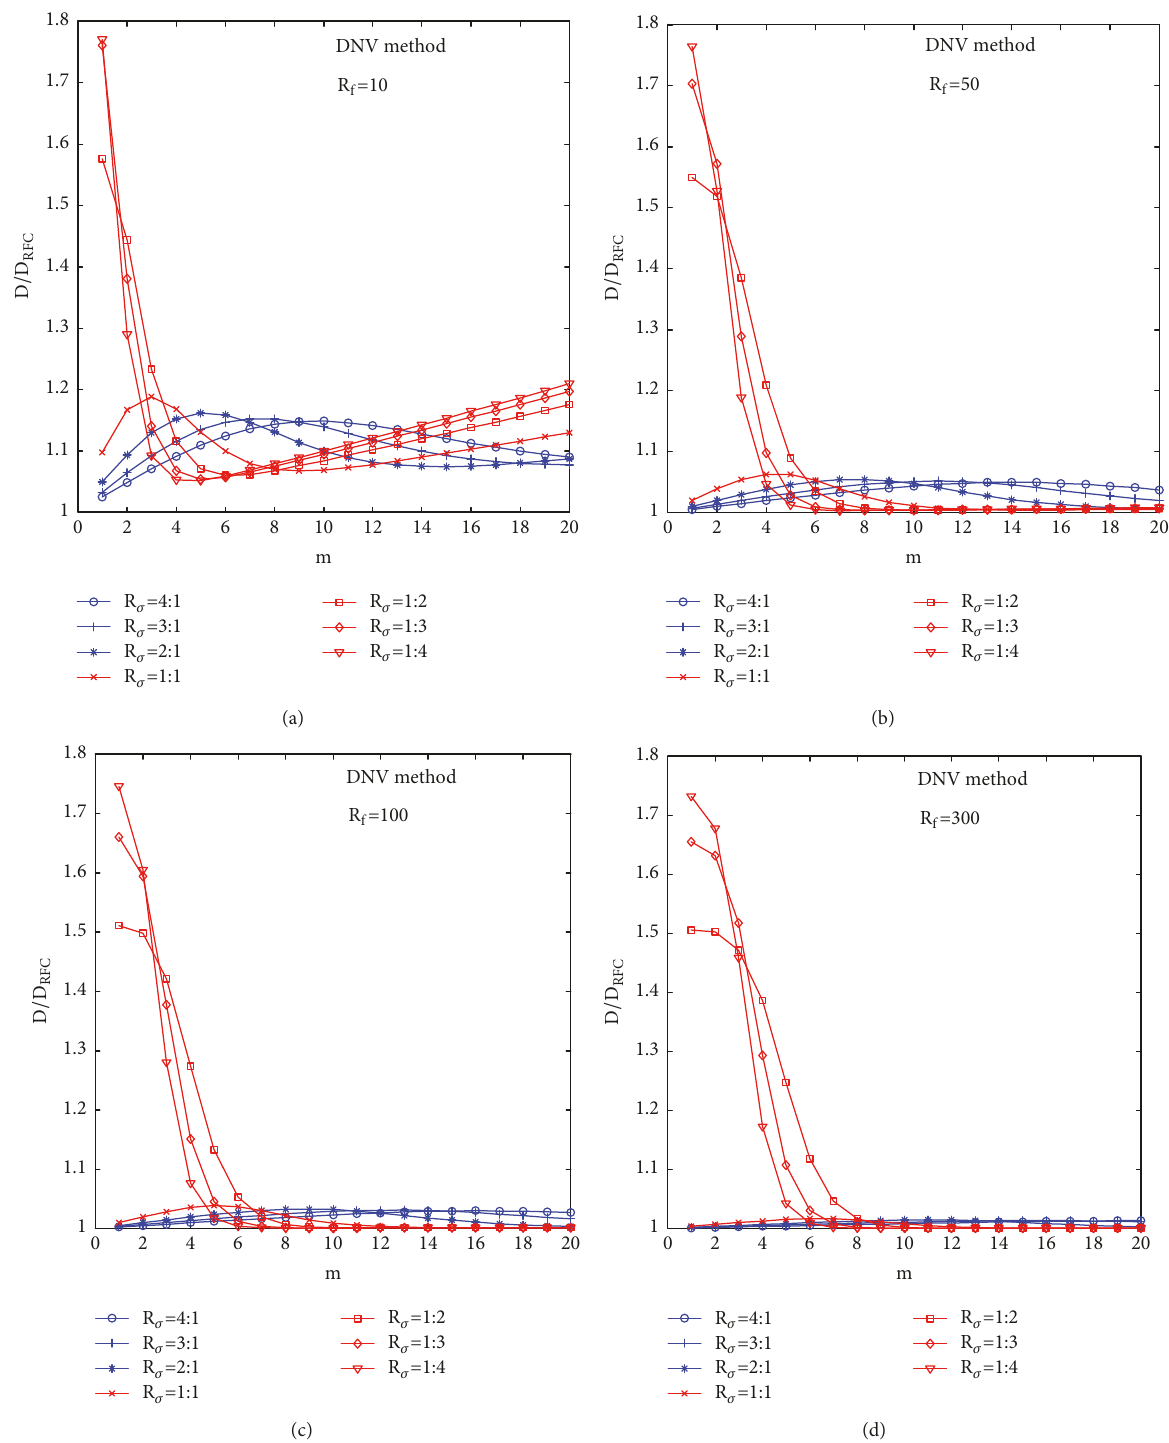
Figure 4: Damage estimation by DNV method in the case of (a) 𝑅 𝑓 = 10 , (b) 𝑅 𝑓 = 50 , (c) 𝑅 𝑓 = 100 , and (d) 𝑅 𝑓 = 300 .